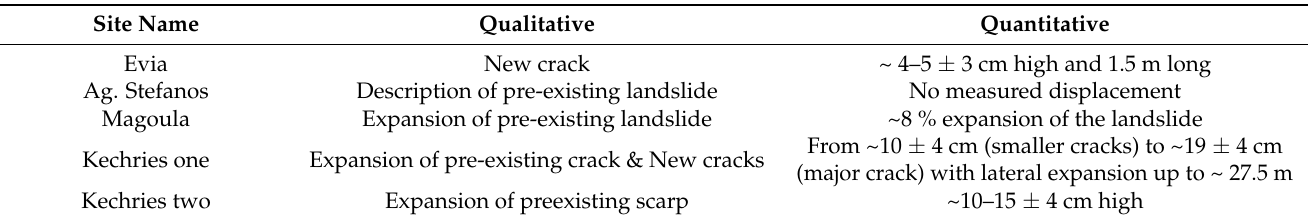
Table 5. Summarised qualitative and quantitative results regarding landslide detection and monitoring for all the examined sites.